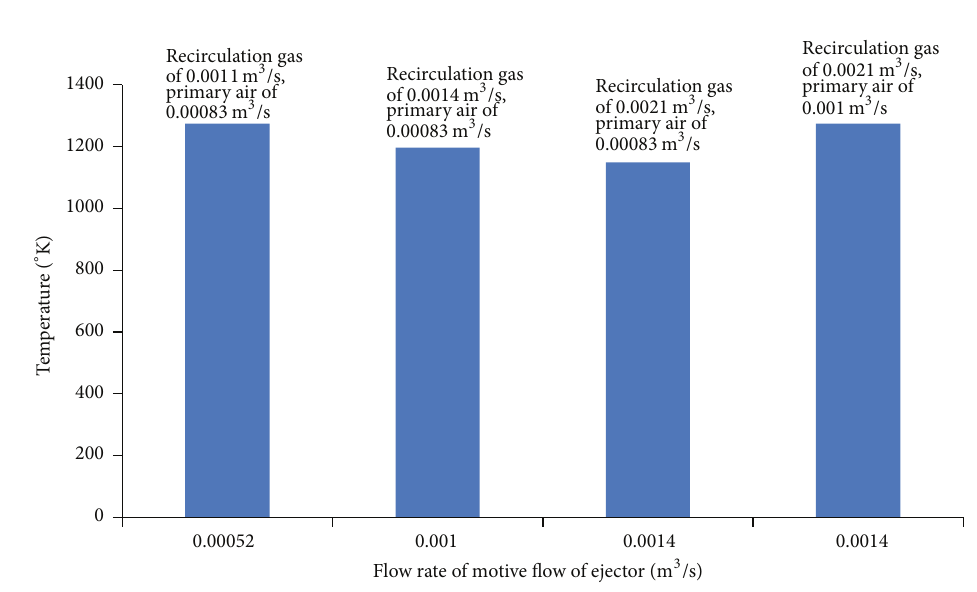
Figure 5: Combustion zone temperature versus motive flow